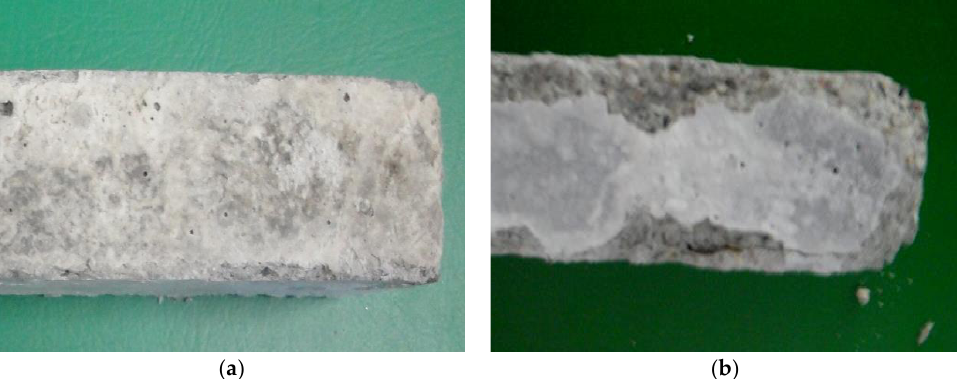
Figure 6. Cement mortar without polymer stored in 5% MgSO 4 solution: ( a ) after 12 months; ( b ) after 42 months.